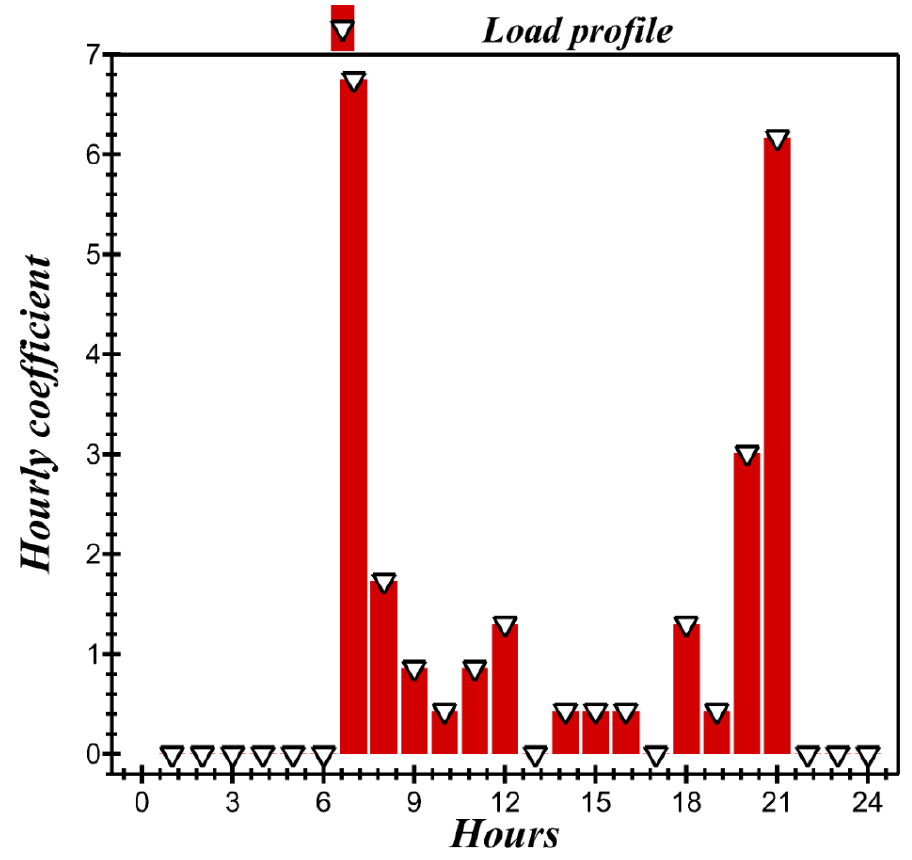
Figure 10. Realistic Moroccan load profile for hot water consumption.